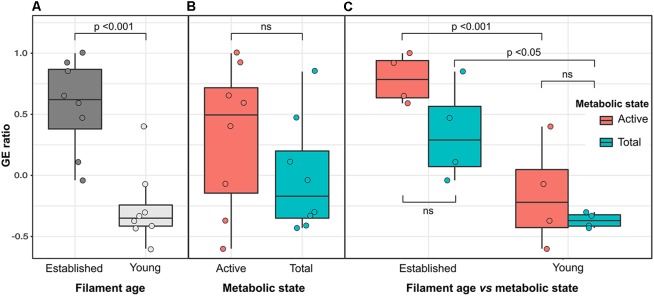
Variation of the Gamma- to Epsilonproteobacteria ratio (GE ratio) between the established (EF) and young filament (YF) communities. (A) Total plus active established vs. young filaments ratio; (B) Active vs. total ratio for established and young filaments combined; (C) Active and total community ratio calculated independently for the established and young filament communities.